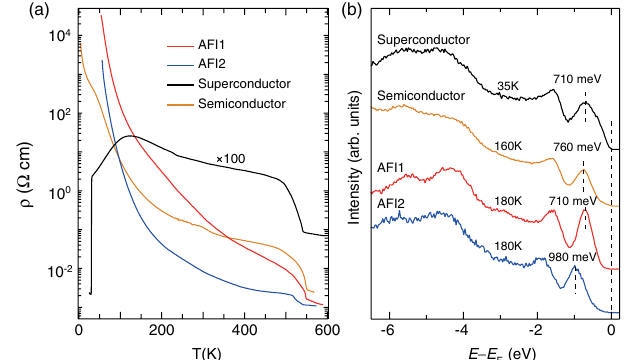
FIG. 1. Resistivities and valence bands of various K x Fe 2 (cid:1) y Se 2 compounds. (a) In-plane resistivities as a function of temperature for the AFI1 and AFI2 insulating compounds, the semiconduct- ing compound, and the superconducting compound with the superconducting-transition temperature ( T c ) of 31 K. The resis- tivity of the superconducting sample is multiplied by 100. (b) Valence-band photoemission spectra at the (cid:2) point for the insulators, semiconductor, and superconductor. The dashed vertical lines are guides to eyes for the peak positions of the feature near (cid:1) 1 eV . If not specified otherwise, data here and hereafter were taken with 21.2 eV photons from an in-house helium-discharge lamp. The data for superconductor, semicon- ductor, and insulators were measured at 35, 160, and 180 K,